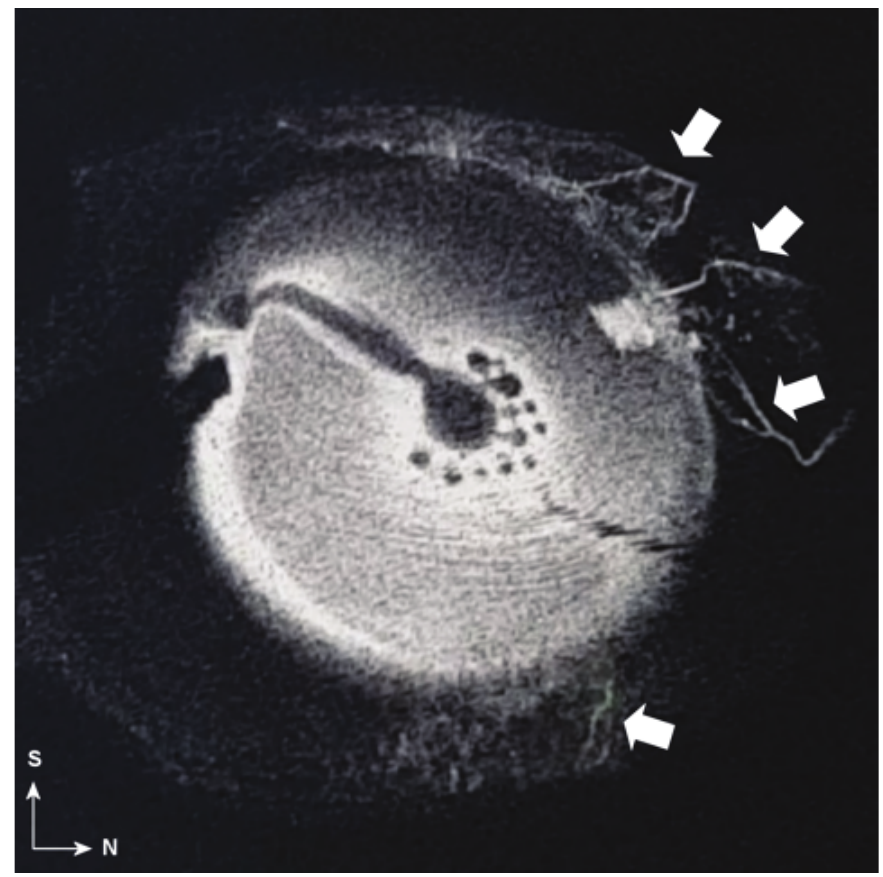
Figure 3. Intraoperative aqueous angiography showing the collector channels (arrows). S, Superior; N,